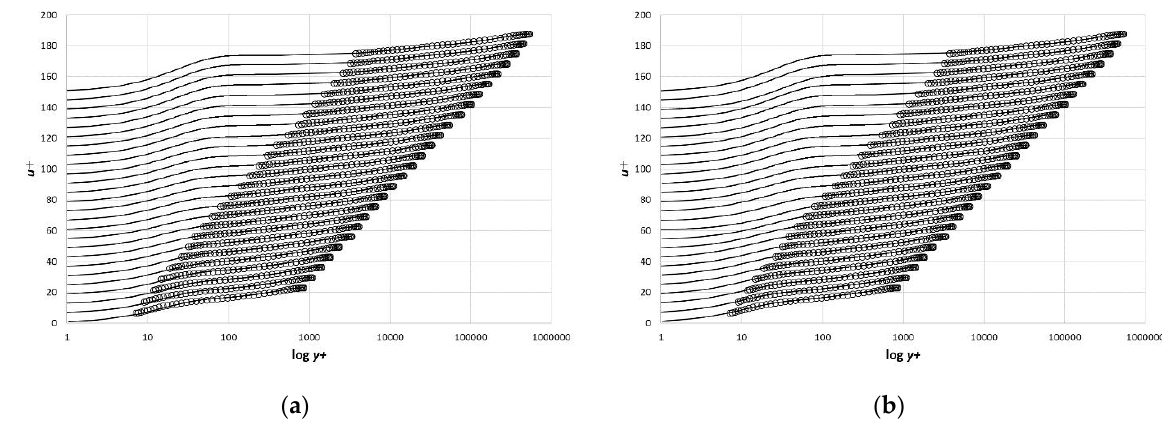
Figure 15. The velocity profiles in the coordinates u + , y + . ( a ) The case of two variables N and K in the optimization process. ( b ) The case of four variables Ω (w) , D (1) , N , and K in the optimization process.